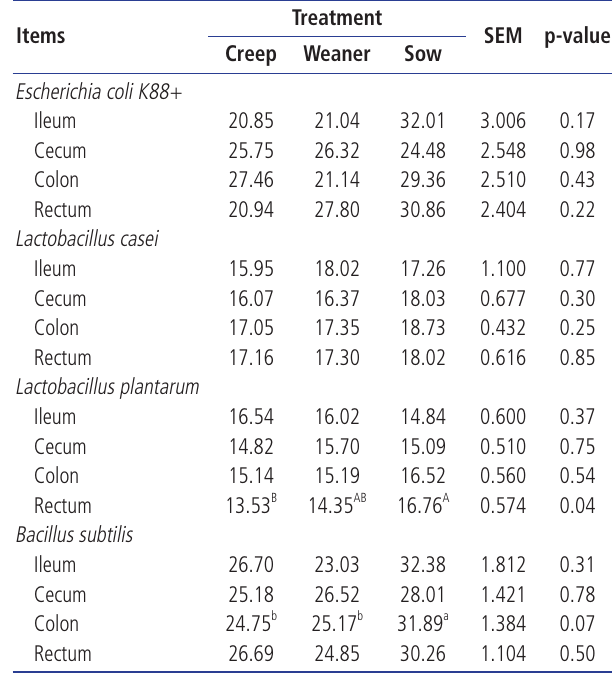
SEM, standard error of the mean. 1) Microflora populations are represented with the Ct value from the real time polymerase chain reaction. AB Means in the same row with different superscript letters were significantly different (p<0.05). ab Means in the same row with different superscript letters were significantly different